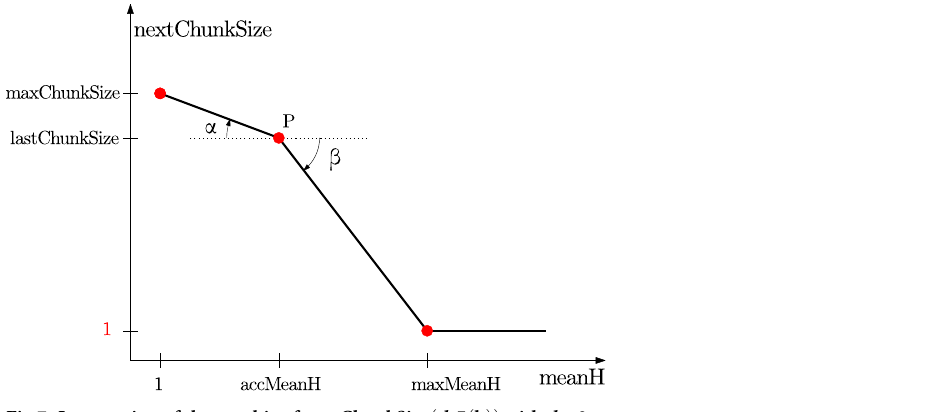
Fig 7. Intersection of the graphic of nextChunkSize ð d ; � e ð h ÞÞ with d = 0.